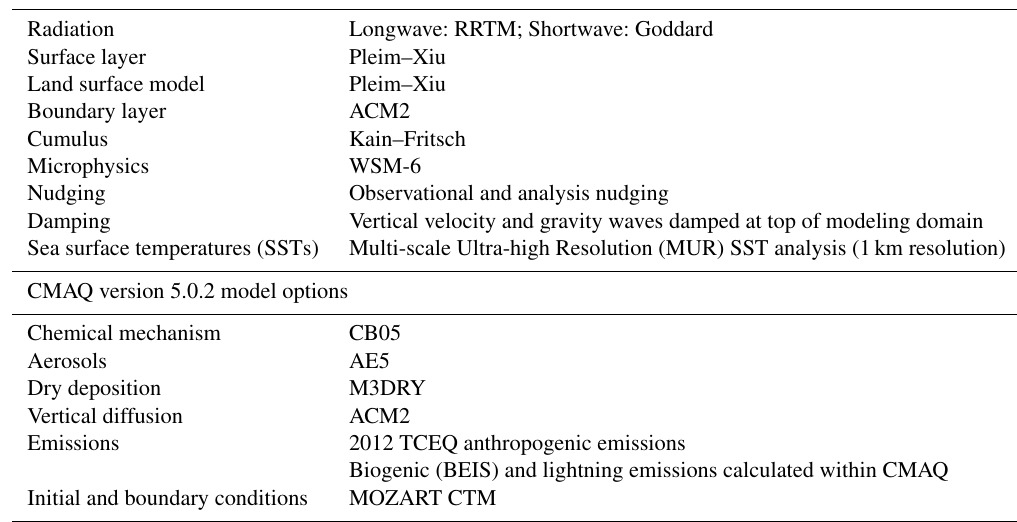
Table 4. WRF and CMAQ model